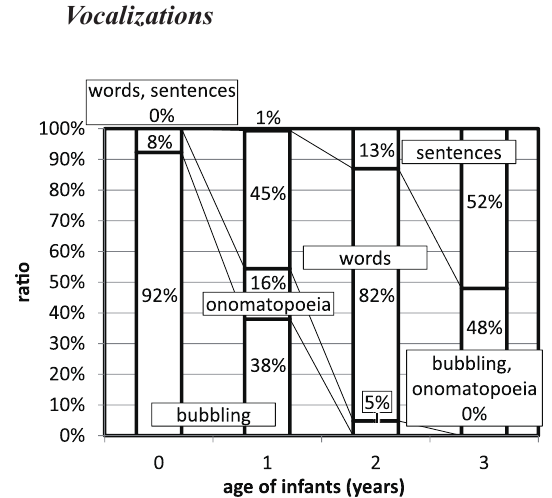
Fig. 5. Frequencies of the Types of Vocalizations According to Ref. 10, bubbling, one word utter- ance and speaking sentences show their peaks at 13, 21 and 30 month of ages, respectively, though the range of children’s age is limited from 13 month to 30 month of age. Meanwhile frequencies of vocal- ization types are on Fig. 5. The peak of bubbling appears at 0 year of age, and also occupies large portion at 1 year of age. One word utterance, and speaking sentences show their peaks at 2 and 3 year of age, respectively.